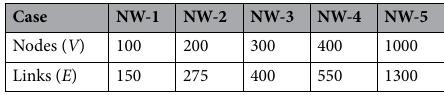
Table 2. Network topology